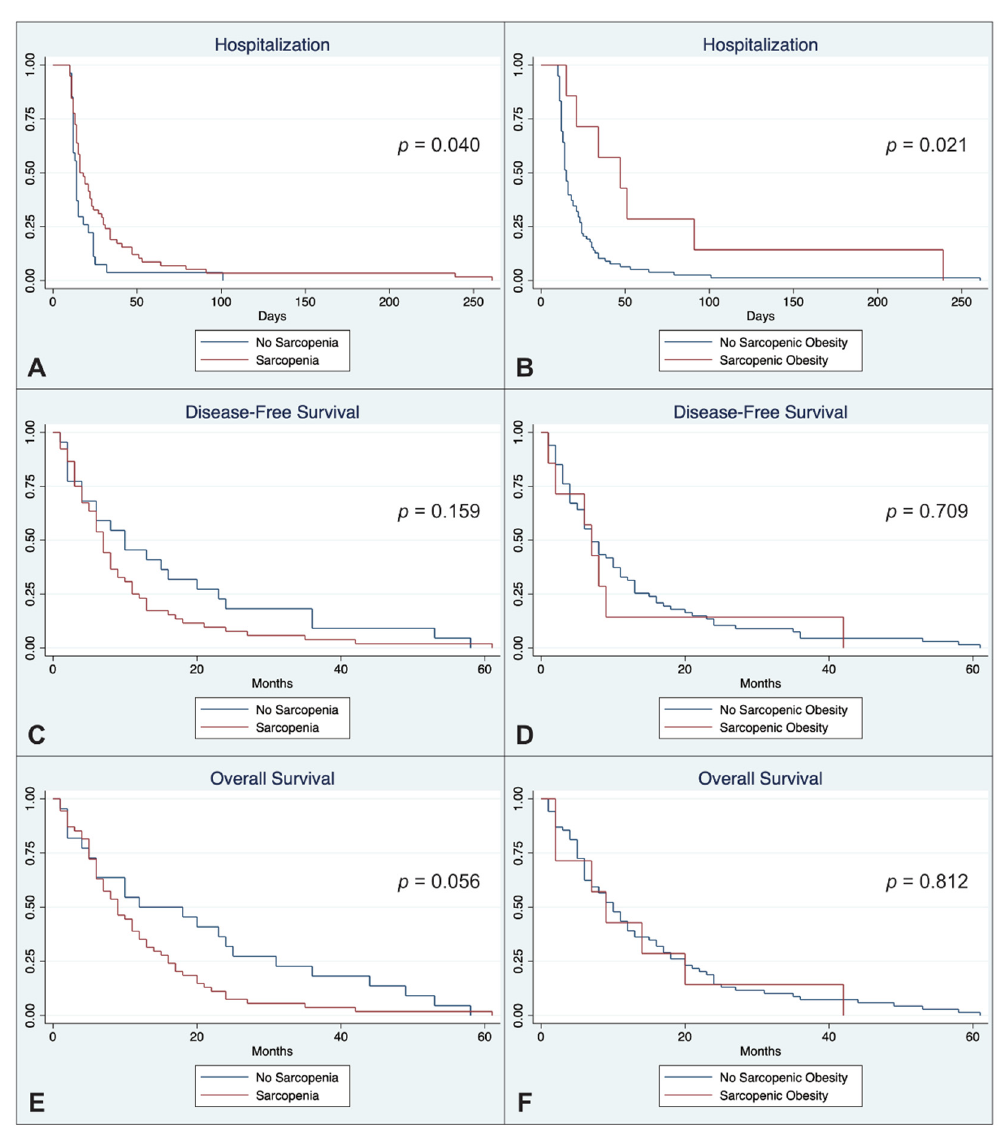
Figure 4. Kaplan-Meier duration of hospitalization ( A , B ), disease-free survival ( C , D ) and overall survival ( E , F ) stratified according to sarcopenia (left column) and sarcopenic obesity (right column).